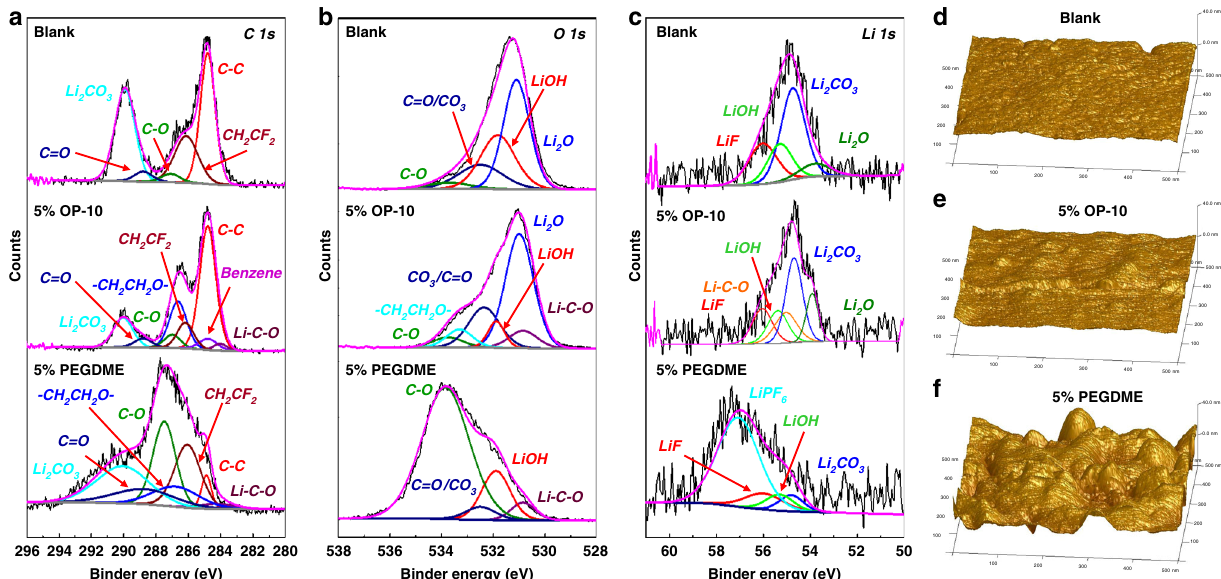
Fig. 4 XPS and AFM analysis of Li anode in different electrolyte systems. C 1s, O 1s, and Li 1s spectra of the SEI fi lm on the surface of the lithium anode without or with OP-10/PEGDME additives after three cycles ( a – c ). AFM images of the electrolyte on the copper foil: blank electrolyte ( d ), 5% OP-10 additives ( e ), 5% PEGDME additives ( f ).